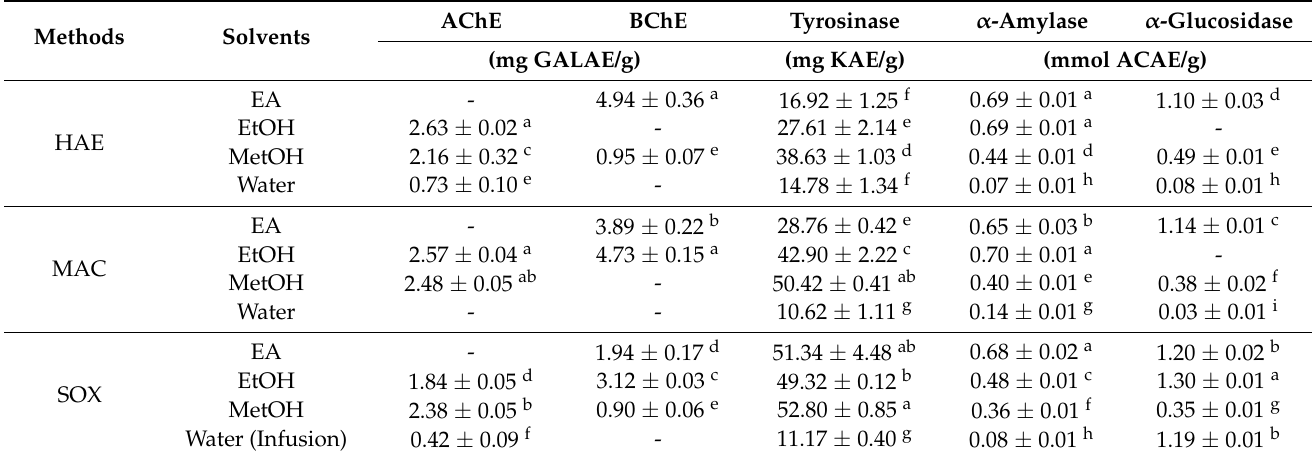
Table 2. Enzyme-inhibiting effects of the tested